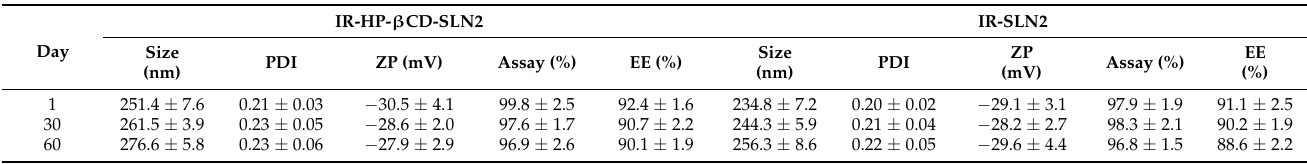
Table 5. Effect of storage at room temperature on physicochemical characteristics of the optimized SLN formulations (mean ± SD, n = 3).